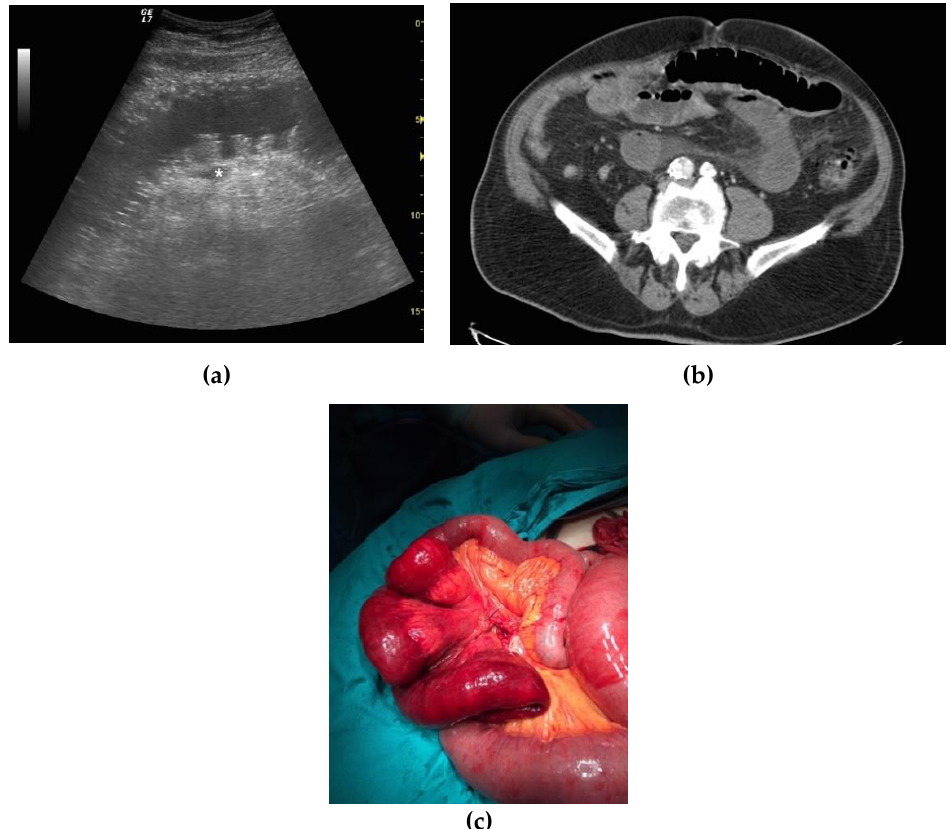
Figure 3. A 79-year-old male patient with previous abdominal surgery with decompensated ileus. ( a ) Ultrasound long axis evaluation of a fluid-filled dilated small bowel loop. Severe parietal and valvulae conniventes thickening were present, and fluid e ff usion adjacent was detected (*). Free fluid between bowel loops was also visualized. Peristalsis was absent. ( b ) CT examination with IV contrast. Fluid filled and air filled small bowel loops. The fluid filled loop appears hypoattenuating due to vascular parietal damage, and perivisceral fat stranding is present; findings were indicative of decompensated SBO. ( c ) At surgery, closed loops of SBO due to a bridle was evident. Vascular compromise was recognized by bluish discoloration of intestinal wall, loss of arterial pulsation, subserosal and mesenteric hemorrhage and a lack of peristalsis. After release of adhesions, bluish discoloration persisted and blocked and damaged sections of the bowel were removed. Table 1. Ultrasound criteria for SBO diagnosis.